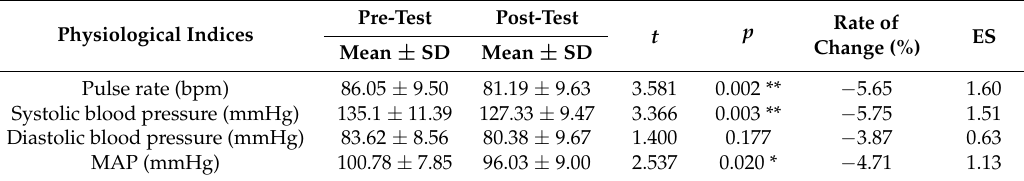
Table 5. Effects of the forest recreation program on physiological stress